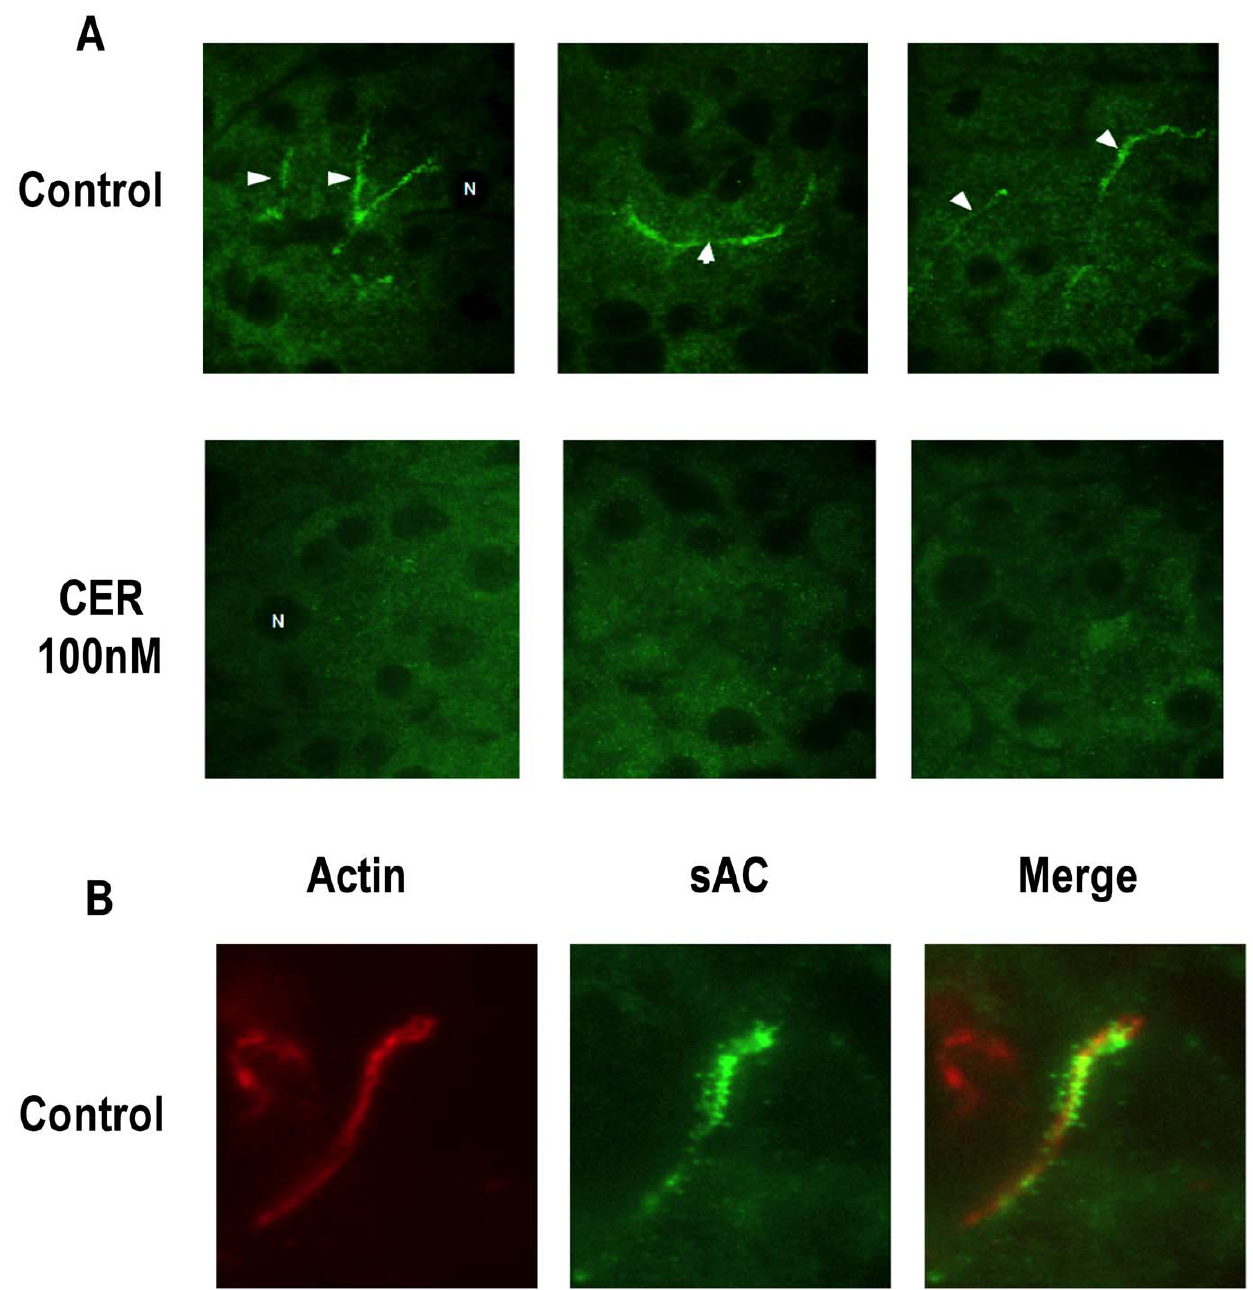
immunoreactivity was concentrated in the apical regions of the acinar cell (arrow heads), but labeling was also observed in the cytoplasm in control tissue (CTL). In CER hyperstimulation (CER) there was a loss of apical staining and the appearance of intense cytoplasmic puncta. 3 representative pictures from different experiments are shown. Representative nuclei are marked with and ‘‘N’’. B) Control tissue probed for both sAC (green) and also f-actin (rhodaminne-phalloidin, red). In the merged co-localization image of sAC with f-actin is